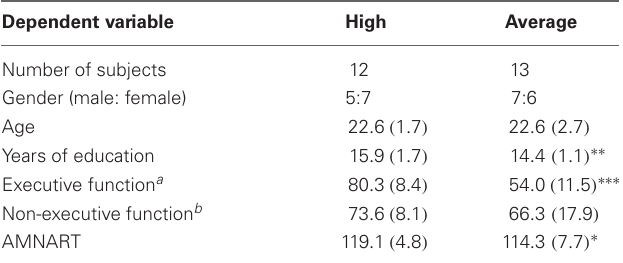
Table 1 | Subject characteristics [mean